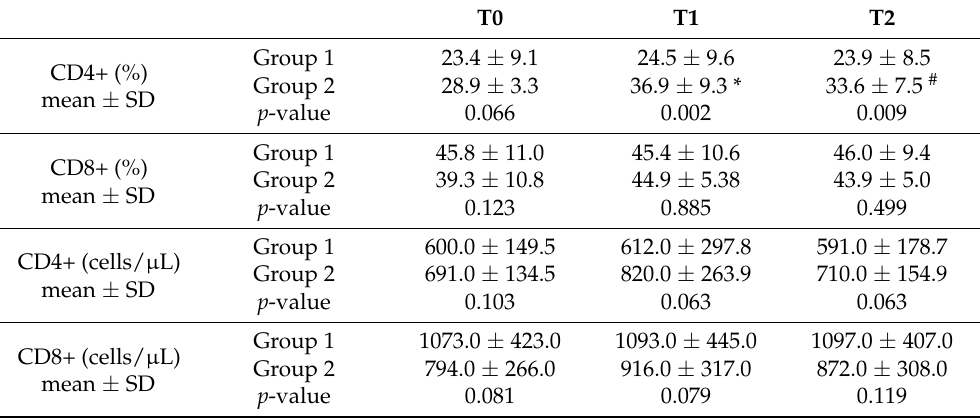
Table 4. Percentage and absolute values of T lymphocyte subpopulation in HIV+ patients at T0 (basal levels), T1 (after four weeks of supplementation), and T2 (after eight weeks of supplementation and four weeks post-immunization). Data were reported as mean ± SD. p -values derived from the contrasts’ analyses are shown in italics. * indicates the statistically significant difference in respect to the basal time. # indicates the statistically significant difference in respect to the previous observation